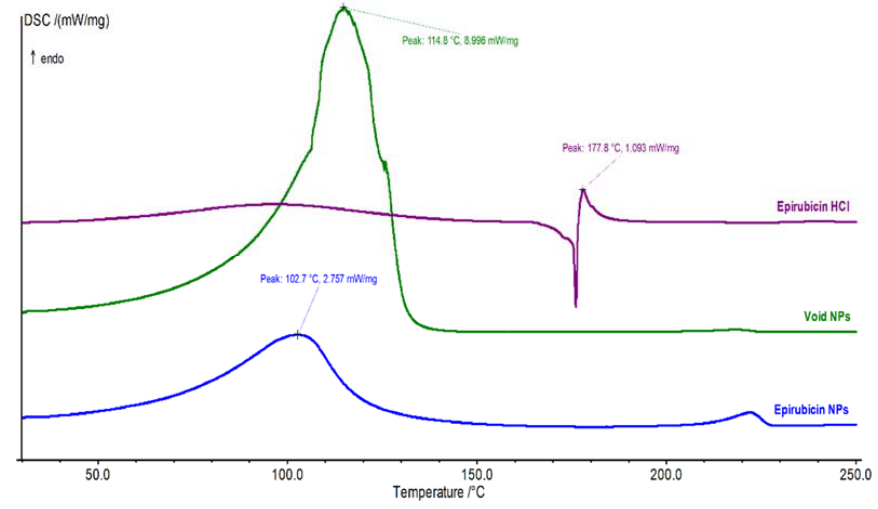
Figure 7. Differential scanning calorimetry thermogram of epirubicin, void and epirubicin-loaded NPs.